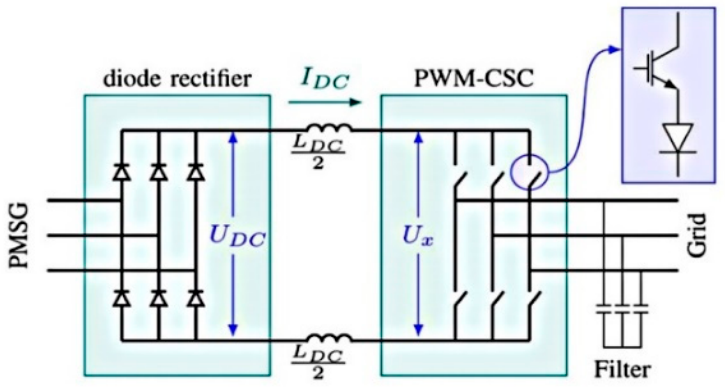
Figure 4. Schematic diagram of the conventional PWM-CSC.